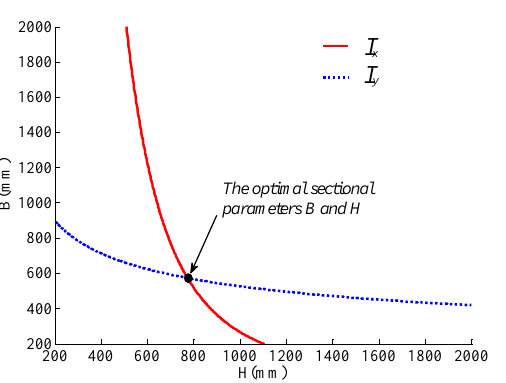
Figure 8. The sectional parameters B and H changing with each other for the minimum inertia moment I x and I y .